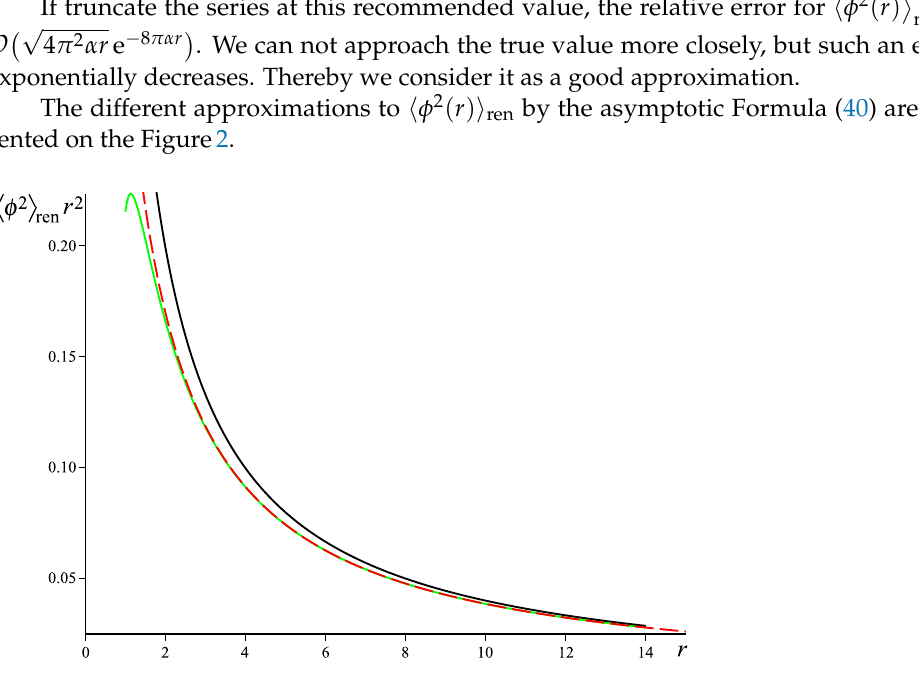
Figure 1. Plots of